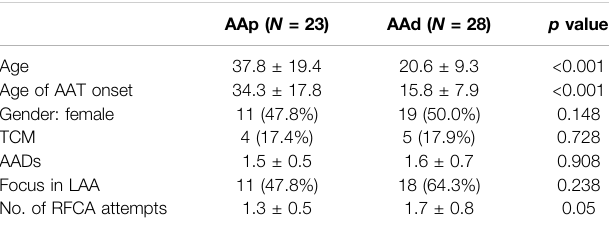
TABLE 1 | Baseline